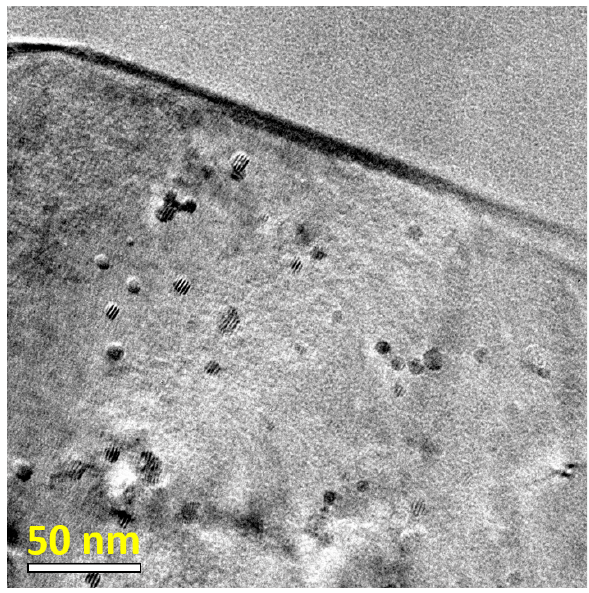
Figure 4. A bright-field TEM image of Al-Sc-based alloy with numerous nanoscale Al 3 Sc-based precipitates.